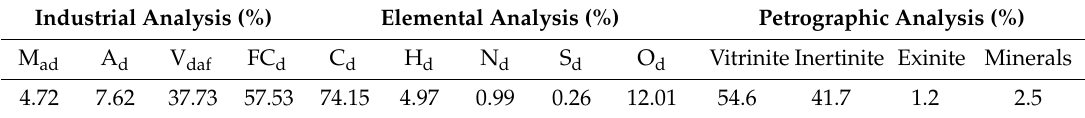
Table 5. The results of Shen-dong coal quality analysis.